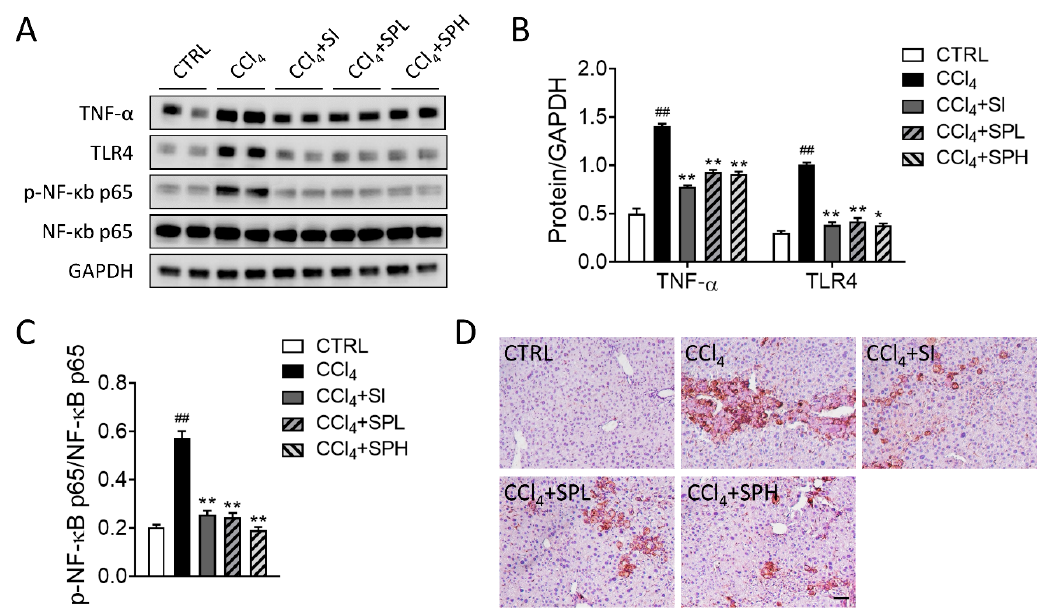
Figure 6. Effects of spore powder of A. camphorata on the expression of TNF- α , TLR4, NF- Κ b (A-C) and the immunohistochemistry staining of F4/80 (D) in liver tissues from mice treated by CCl 4 . Data are presented as mean ± SEM (n = 6). Different letters indicate significantly different values according to a one-way ANOVA using Tukey’s test for multiple comparisons. Compared with control group (CTRL), ## p < 0.01; compared with CCl 4 -induced group (CCl 4 ), * p < 0.05, ** p < 0.01. TNF- α , tumor necrosis factor alpha; TLR4, toll like receptor 4; NF- Κ b, nuclear factor- Κ b; CTRL, control group; CCl 4 , carbon tetrachloride; SI, silymarin; SPL, low-dose treatment with spore powder of A. camphorata ; SPH, low-dose treatment with spore powder of A. camphorata .